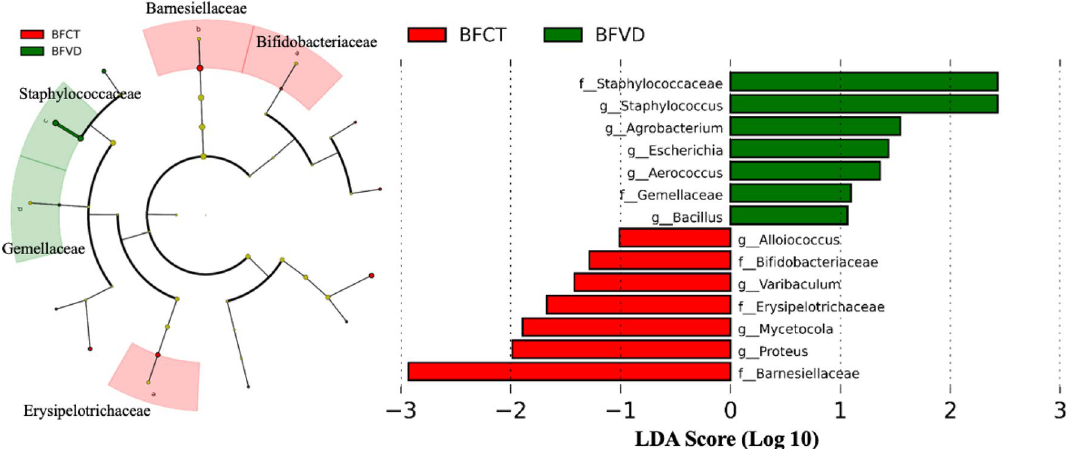
Figure 6. Identification of the most differentially taxa between breastfed infants with vitamin D